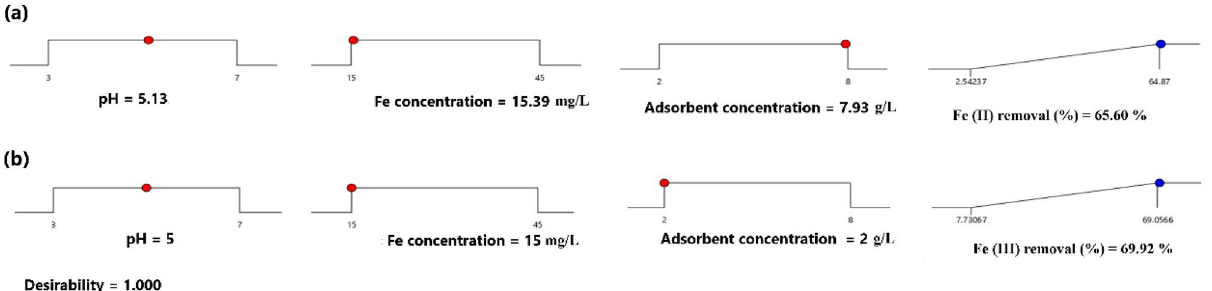
Figure 4. Desirability ramp plot for optimization of ( a ) Fe(II) and ( b ) Fe(III) from single